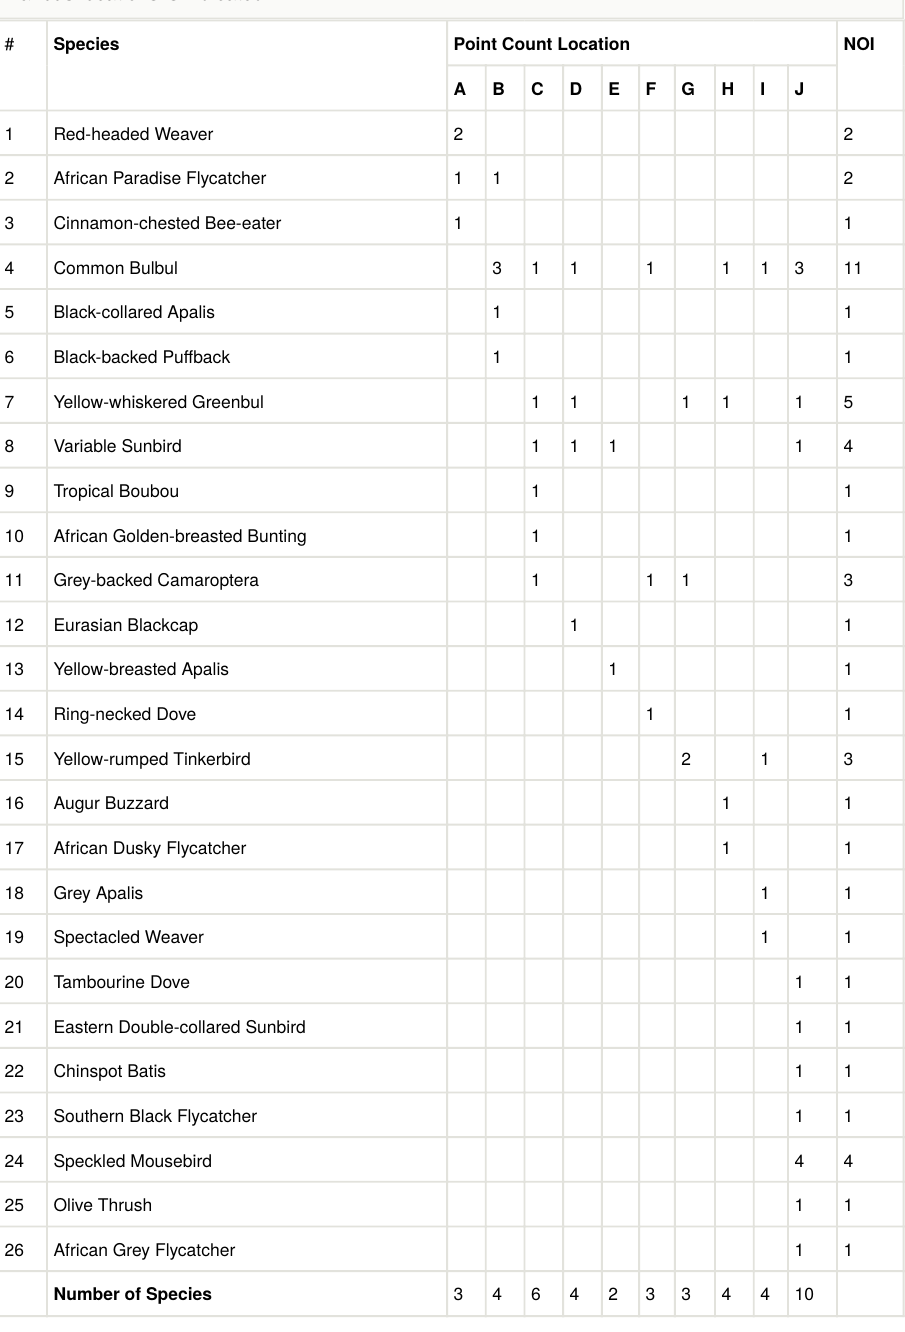
Table 2. Results of the point count on 5th January, 2016. The number of individuals (NOI) observed at various locations is #